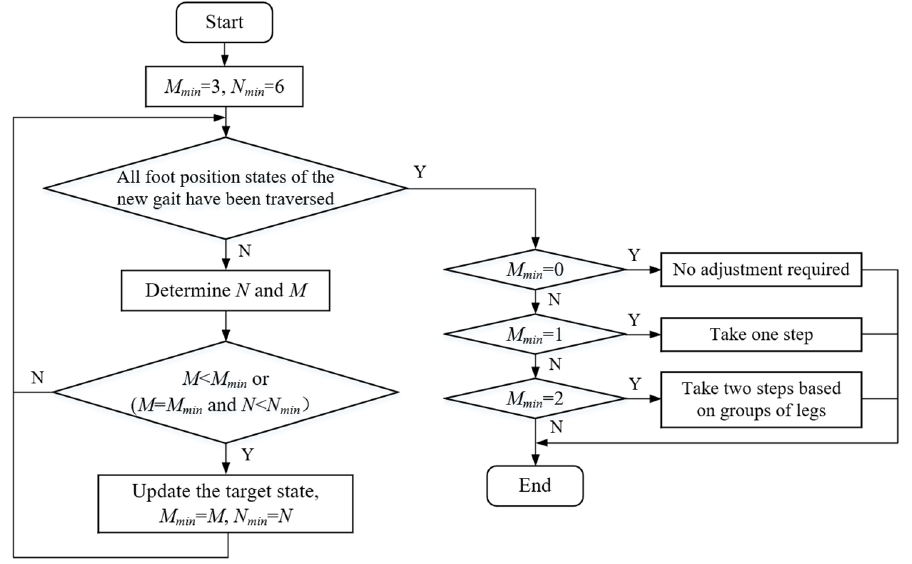
Figure 8. Flow chart of gait transformation.